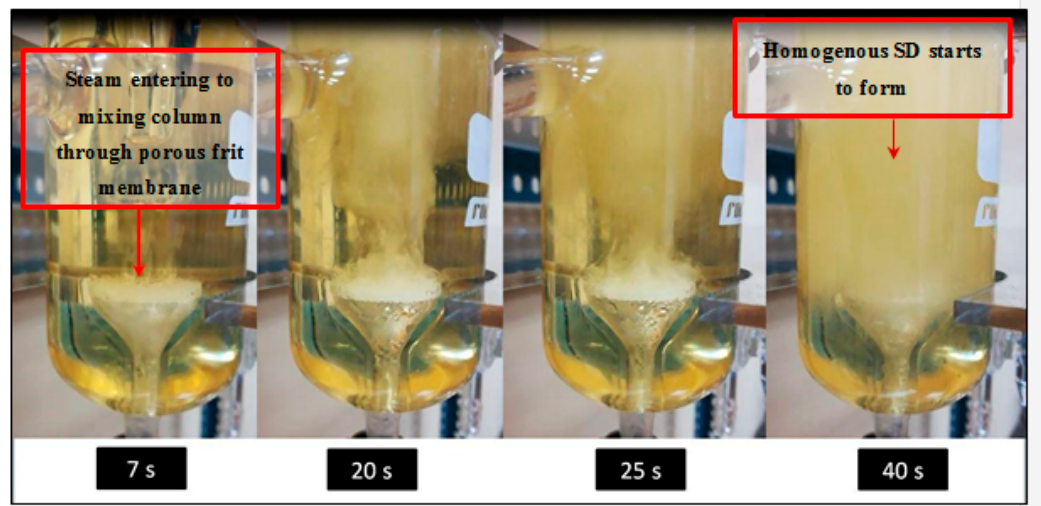
Figure 5. Sequence formation of SD via steam emulsification.